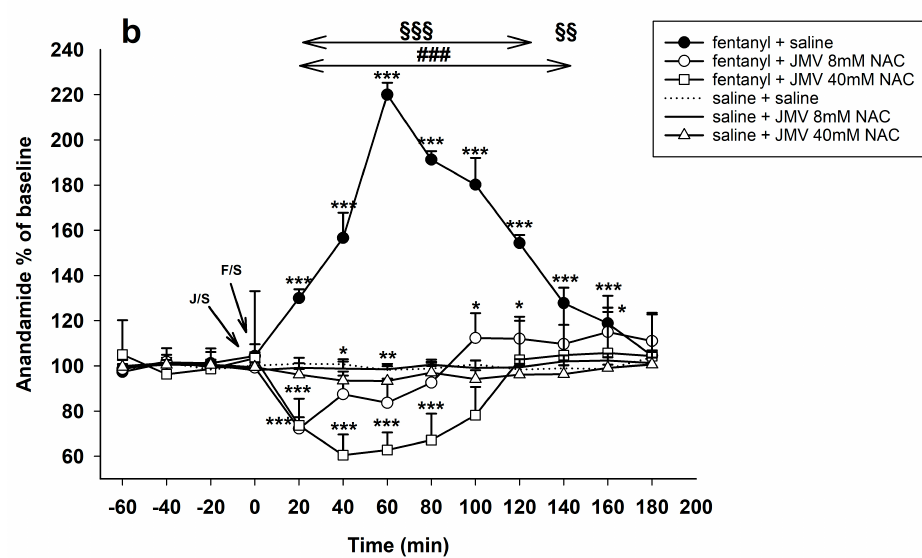
Figure 2. Effects of growth hormone secretagogue receptor (GHS-R1A) antagonist JMV2959 administered following four 20 min baselines into the ventral tegmental area (VTA) or into the nucleus accumbens (NAC) always 5 min before fentanyl/saline on the accumbens AEA levels (means ± SEM). The effects are illustrated as follows: ( a ) Ringer’s solution/VTA + fentanyl (filled circle), 2 µg JMV2959/VTA + fentanyl (open circle), 10 µg JMV2959/VTA + fentanyl (open square), 2 µg JMV2959/VTA + saline (continuous line), 10 µg JMV2959/VTA + saline (open triangle), and Ringer’s solution + saline (dotting); and ( b ) saline + fentanyl (filled circle), JMV2959 lower dose 8 mM/15 min/NAC + fentanyl (open circle), JMV2959 higher dose 40 mM/15 min/NAC + fentanyl (open square), JMV2959 lower dose 8 mM/15 min/NAC + saline (continuous line), JMV2959 higher dose 40 mM/15 min/NAC + saline (open triangle), and Ringer’s solution + saline (dotting). Differences between treatments and the control group (Ringer’s/VTA + saline or saline + saline) are expressed as *** p < 0.001, ** p < 0.01, * p < 0.05. Differences between fentanyl and fentanyl in combinations with the higher JMV2959 dose (10 µg/VTA or 40 mM/15 min/NAC, respectively) are expressed as ### p < 0.001, ## p < 0.01. Differences between fentanyl and fentanyl in combinations with the lower JMV2959 dose (2 µg/VTA or 8 mM/15 min/NAC, respectively) are expressed as §§§ p < 0.001, §§ p < 0.01. The horizontal arrows show intervals with appropriate significant changes ( §§§ or ### ); the oblique arrows show the time of administration of J/S = JMV2959/saline or J/R = JMV2959/Ringer´s solution and F/S = fentanyl/saline.